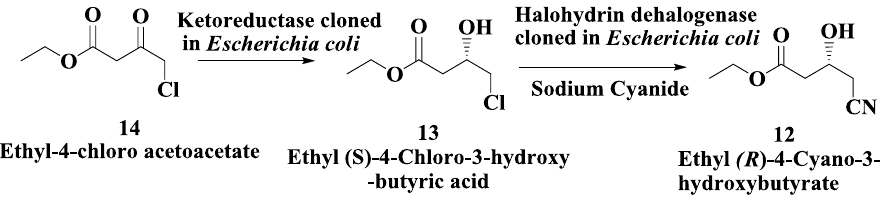
Figure 3. Atorvastatin: Enzymatic preparation of ( R )-4-cyano-3-hydroxybutyrate.